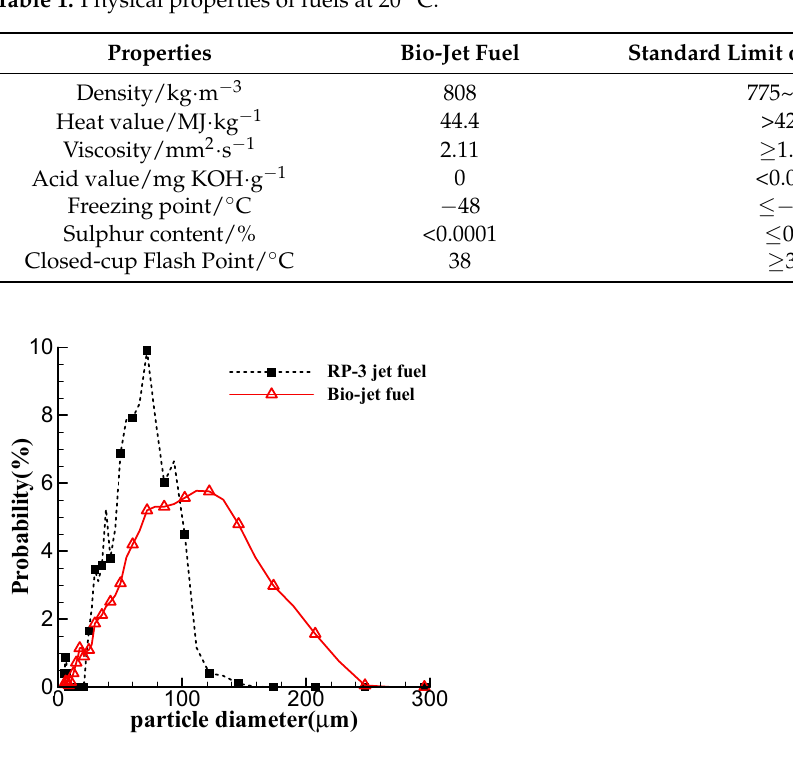
Figure 1. Technology route of the bio-jet fuel preparation.